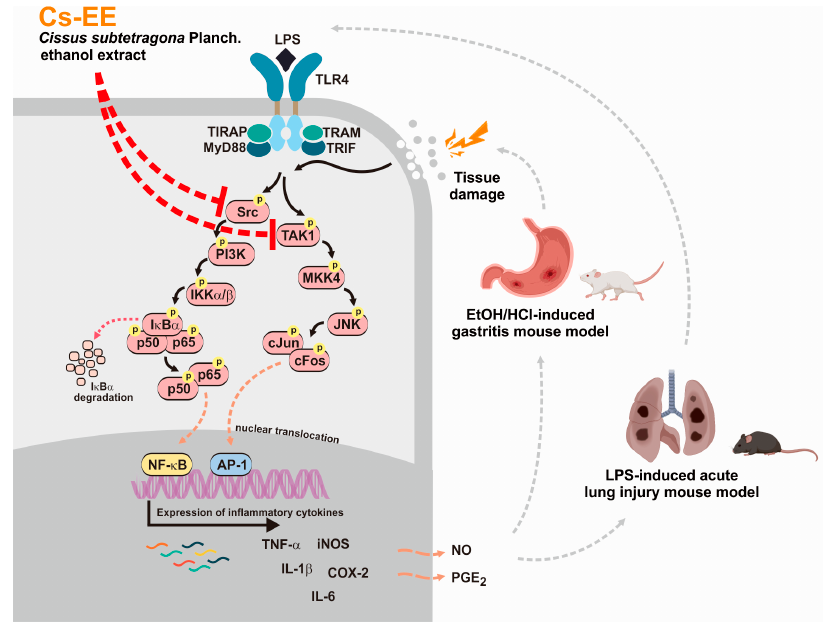
Figure 8. Schematic: anti-inflammatory mechanisms of Cs-EE in the inhibition of NF- κ B and AP-1 signaling pathways via attenuation of Src and TAK1 activation.